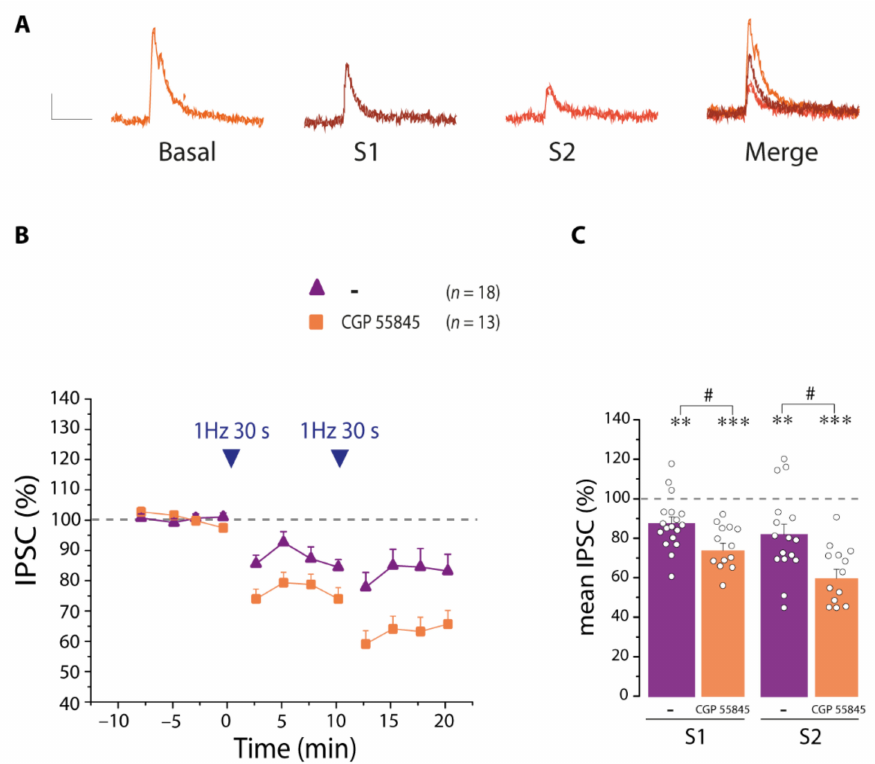
Figure 8. Blocking GABA B Rs induces a stronger disinhibition of PNs. ( A ) Representative IPSCs before (basal) and after the first (S1) and the second (S2) 30 light pulses and merger of all IPSCs, in the presence of the GABA B R antagonist CCP 55845. Scale bar, 50 ms, 10 pA. ( B ) Mean normalized IPSCs amplitude before and after the 30 light pulse stimulation in the presence of CGP 55845 ( n = 13) ( C ) Quantification of the mean normalized IPSC amplitude during the 10 min after the first (S1) and second (S2) stimulation in the absence or presence of CGP55845. Note the increased disinhibition after blocking GABA B Rs. * statistical comparison with basal conditions, ** p < 0.01, *** p < 0.001, paired t -test. # statistical comparison in the absence and presence of antagonist, # p < 0.05, unpaired t -test. Note also that in this figure and the other figures reporting IPSC amplitudes in the presence of antagonists, the control values reported in Figure 7 have been plotted again to facilitate the comparison of PNs disinhibition in the absence and presence of antagonists.